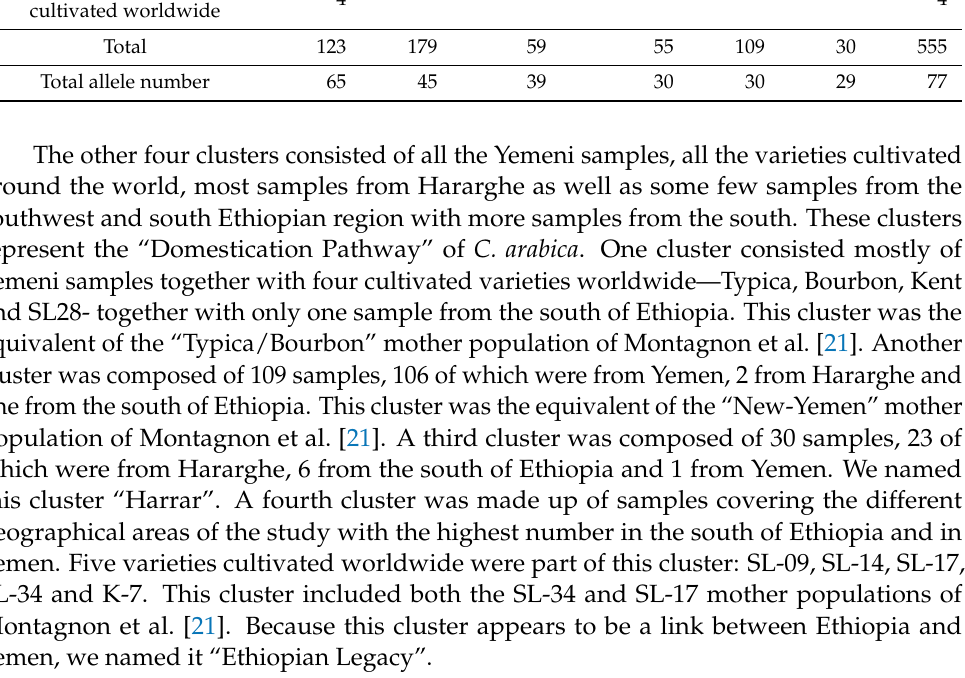
Table 3. Repartition of studied coffee samples according to their geographical origin and ge- netic cluster. Core Ethiopia Domestication Pathway Samples Core Core Ethiopian Typica New- Areas Harrar Total Origin Eth. 1 Eth. 2 Legacy Bourbon Yemen Southwest 62 46 5 113 Ethiopia South 54 133 COE Survey Yemen Survey 186 5 4 9 4 4 Total